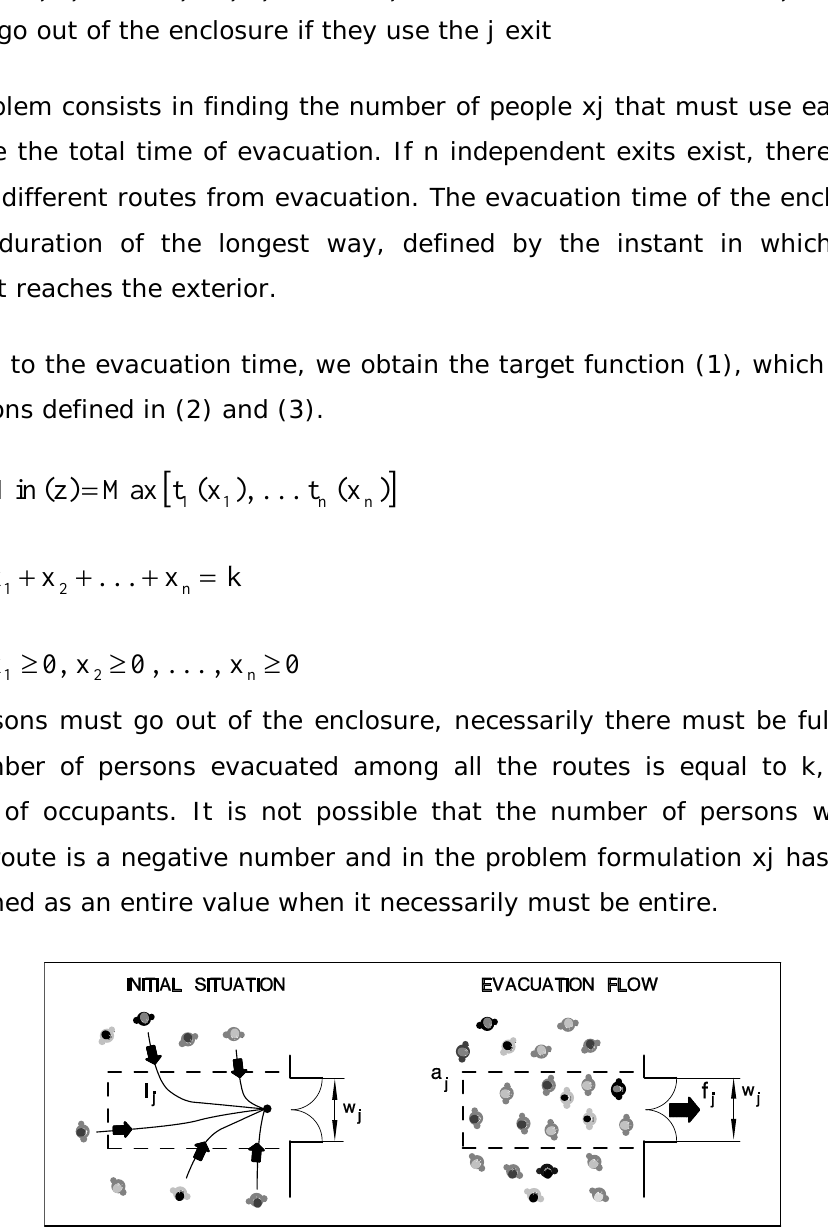
Figure 2. “Modeling the incorporations to the